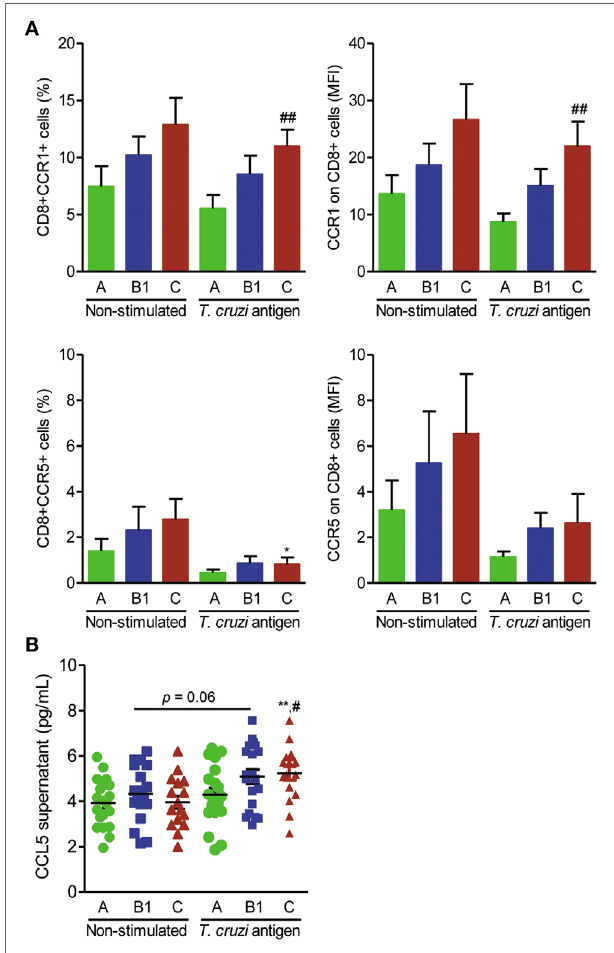
FigUre 5 | Expression of CCR1 + and CCR5 + on CD8 + T cells and CCL5 production after antigen stimulation in association with the severity of Chagas heart disease. Peripheral blood cells of Chagas disease (CD) patients grouped as A (asymptomatic, n = 20), B1 [mild chronic chagasic cardiomyopathy (CCC), n = 20], or C (severe CCC, n = 16) were collected and stimulated with T. cruzi antigen for 24 h. Cells and supernatants were harvested and analyzed for cell markers by flow cytometry and CCL5 production by enzyme-linked immunosorbent assay. ( a) Frequencies of CCR1 + and CCR5 + cells and mean fluorescence intensity (MFI) of CCR1 and CCR5 on CD8 + T cells; ## P < 0.01, antigen-stimulated cells from patients in group C vs group A [analysis of variance (ANOVA), Bonferroni posttest]. (B) CCL5 concentrations in supernatants of cell cultures of CD patients grouped as A, B1, and C; ** P < 0.01, antigen-stimulated vs nonstimulated cells from patients in group C (ANOVA, Bonferroni posttest); ## P < 0.01, antigen-stimulated cells from patients of group C vs group A (ANOVA, Bonferroni